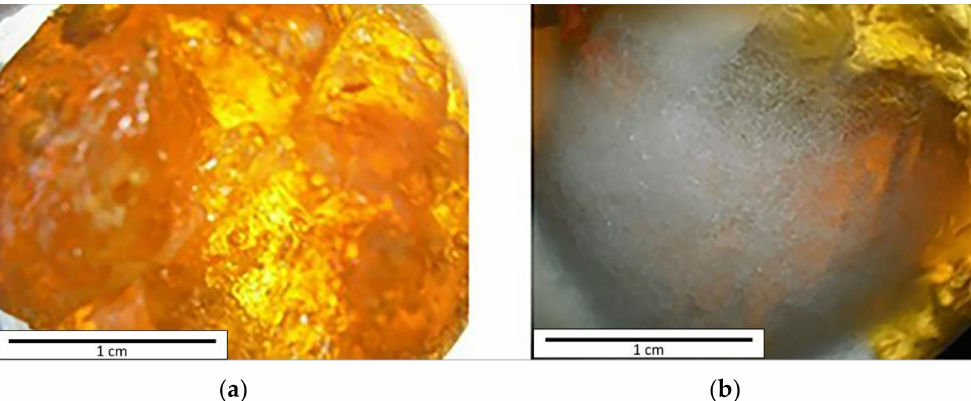
Figure 1. Photographs of the surfaces of BSA/GLA hydrogels prepared in accordance with the formulation specified for commercial BioGlue: ( a ) freshly prepared BSA/GLA hydrogel and ( b ) surface fungal contamination (grey) of a BSA/GLA sample left standing in the atmosphere for 4